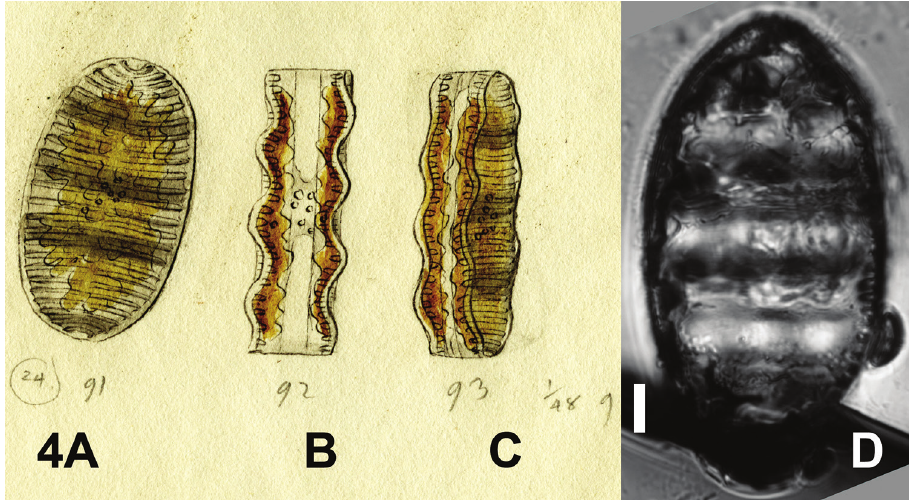
Figure 4. Surirella undulata . A–C Drawing BHUPM 1163 D Lectotype: BHUPM 540138-6, Trock- enpräparate CXXXVIII 6. Scale bar for D = 10